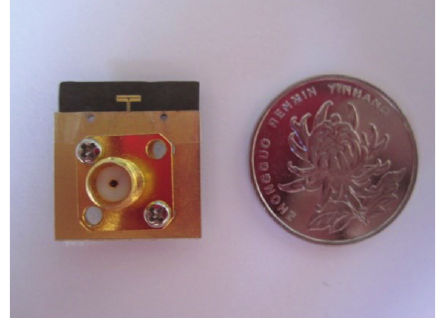
Figure 9: The front of the proposed